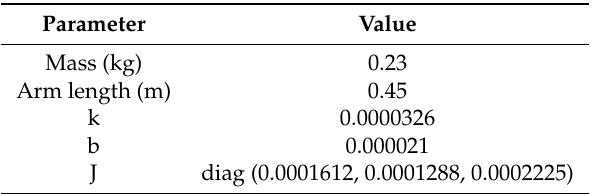
Table 2. State vector of the quadrotor helicopter